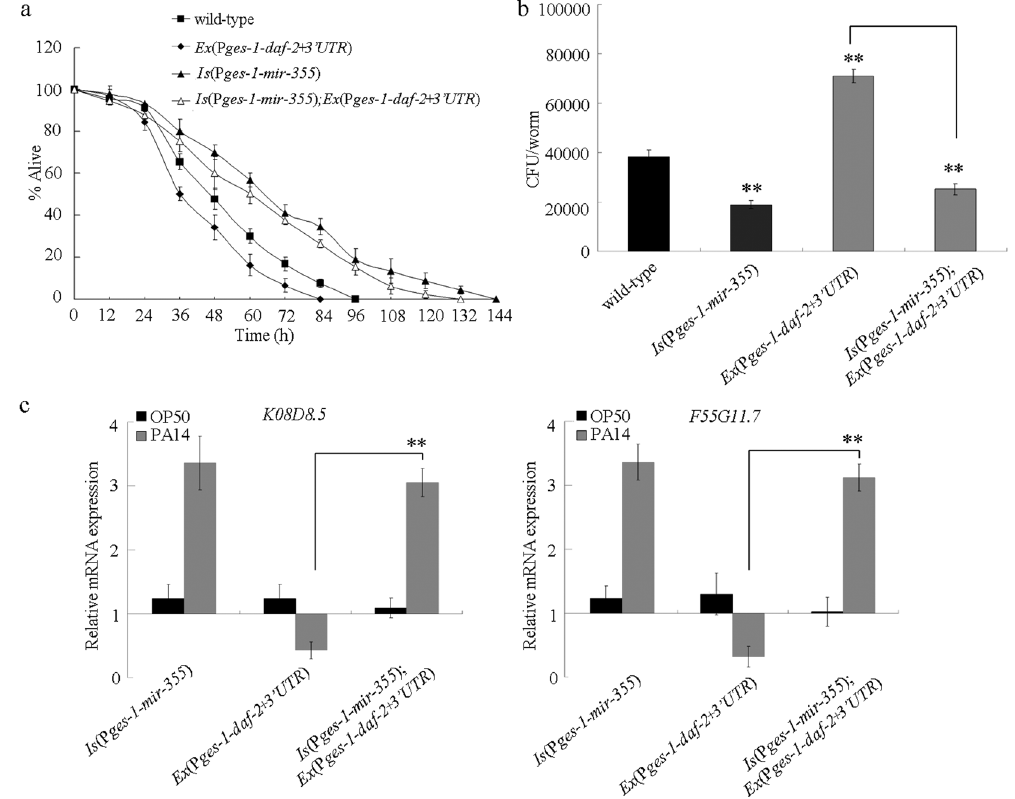
Figure 6. Effects of intestinal overexpression of daf-2 containing 3 ′ UTR on innate immune response to P. aeruginosa PA14 infection in nematodes overexpressing intestinal mir-355 . ( a ) Effects of intestinal overexpression of daf-2 containing 3 ′ UTR on survival of nematodes overexpressing intestinal mir-355 after P. aeruginosa PA14 infection. Statistical comparisons of the survival plots indicate that, after the P. aeruginosa PA14 infection, the survival of transgenic strain Is( P ges-1-mir-355);Ex( P ges-1-daf-2 + 3 ′ UTR) was significantly different from that of transgenic strain of Ex( P ges-1-daf-2 + 3 ′ UTR) ( P < 0.001). Bars represent mean ± SD. ( b ) Effects of intestinal overexpression of daf-2 containing 3 ′ UTR on P. aeruginosa PA14 CFU in the body of nematodes overexpressing intestinal mir-355 . Bars represent mean ± SD. ** P < 0.01 vs wild-type (if not specially indicated). ( c ) Effects of intestinal overexpression of daf-2 containing 3 ′ UTR on expression patterns of putative antimicrobial genes of nematodes overexpressing intestinal mir-355 after P. aeruginosa PA14 infection. Normalized expression is presented relative to wild-type expression. Bars represent mean ± SD. ** P <